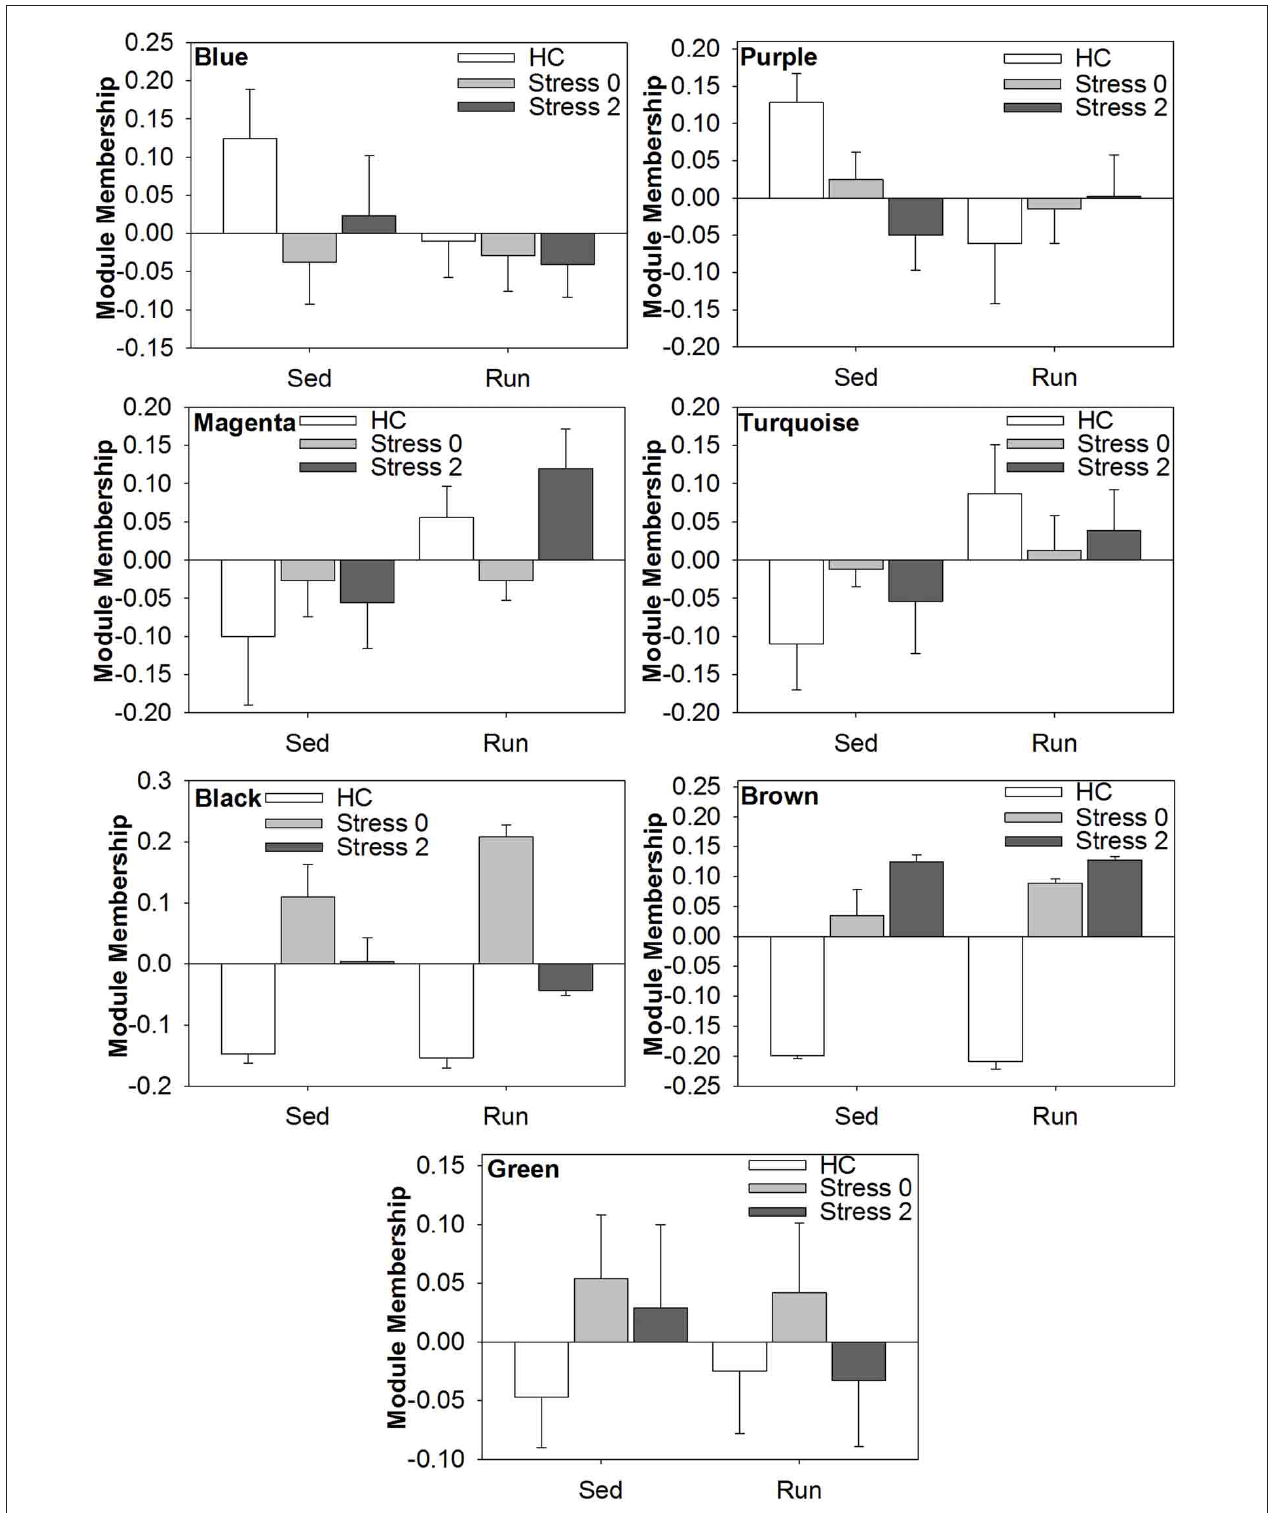
FIGURE 5 | Effect of exercise and/or stress on modules of coexpressed genes in the DRN.